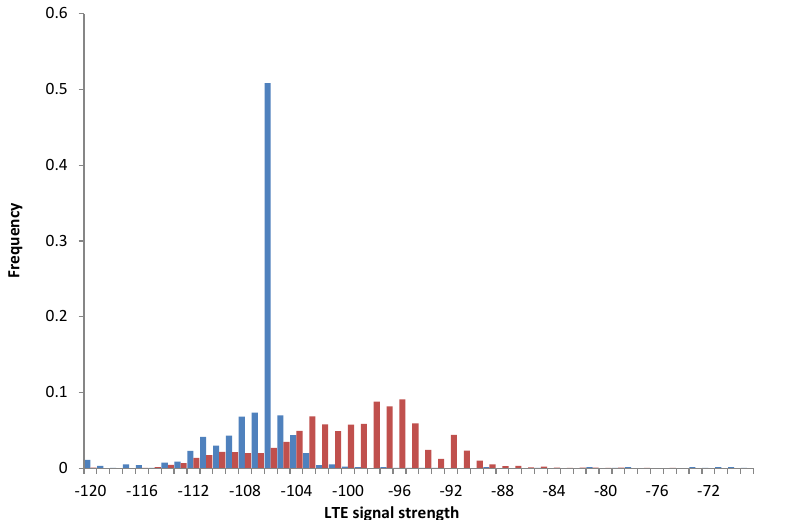
Figure 12. Comparison of signal strengths for a smartphone (blue) vs . a tablet (red) used in the same office room (Experiment 2).